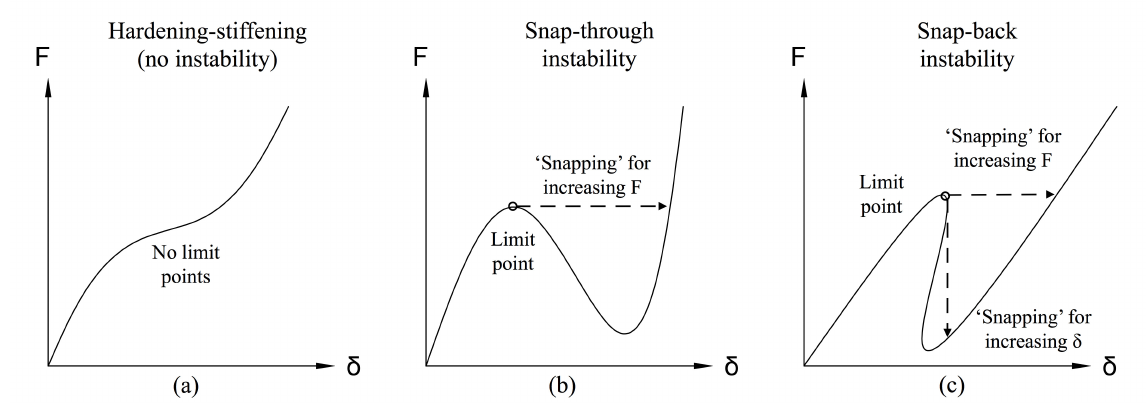
Figure 1: Equilibrium curves exhibiting different stability phenomena: (a) hardening-stiffening behavior (no instability); (b) snap-through instability; (c) snap-back